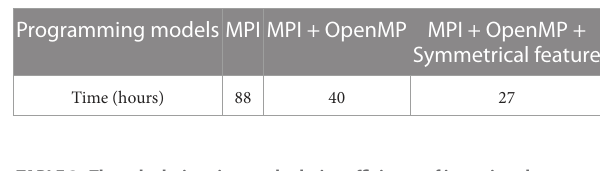
TABLE1 Thecalculatingtimeofcomputingthenormalequation ( N 58077×58077 ) bytheparallelnumericalalgorithm.Thecalculationusedsix nodeswith108coresfromtheHPCclusterintheSchoolofGeodesyand Geomatics,WuhanUniversity.